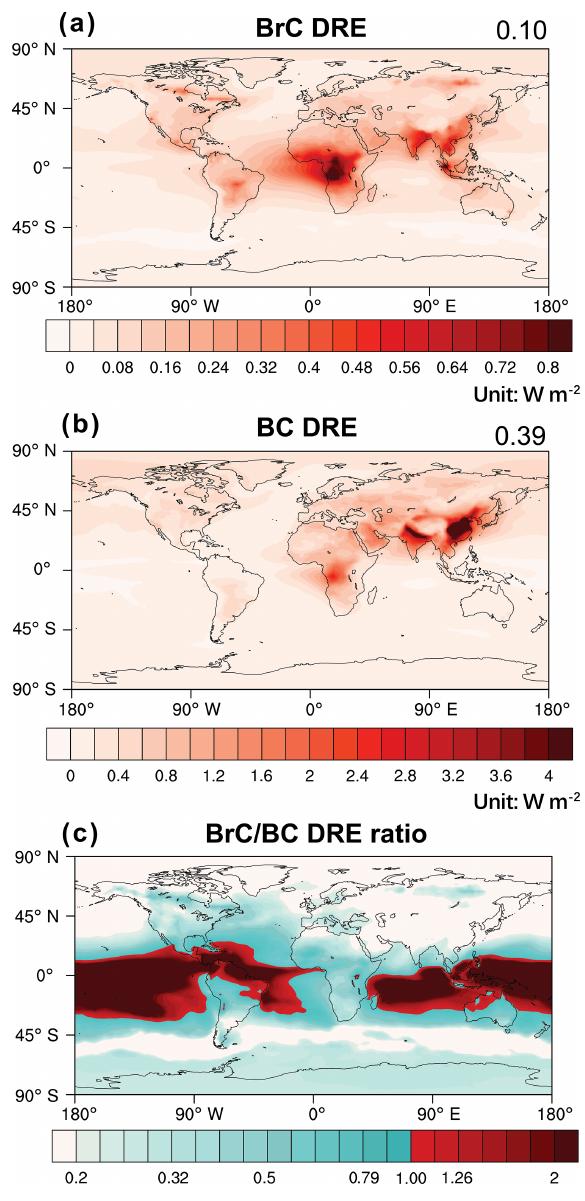
Figure 10. Annual averaged global distributions of (a) BC DRE, (b) BrC DRE and (c) the ratio of BrC / BC DRE for 2010. The unit is Wm − 2 . The global averaged DRE is shown in the upper right corner. In (c) , BrC / BC DRE ratios larger than 1.0 are specified by a differently colored